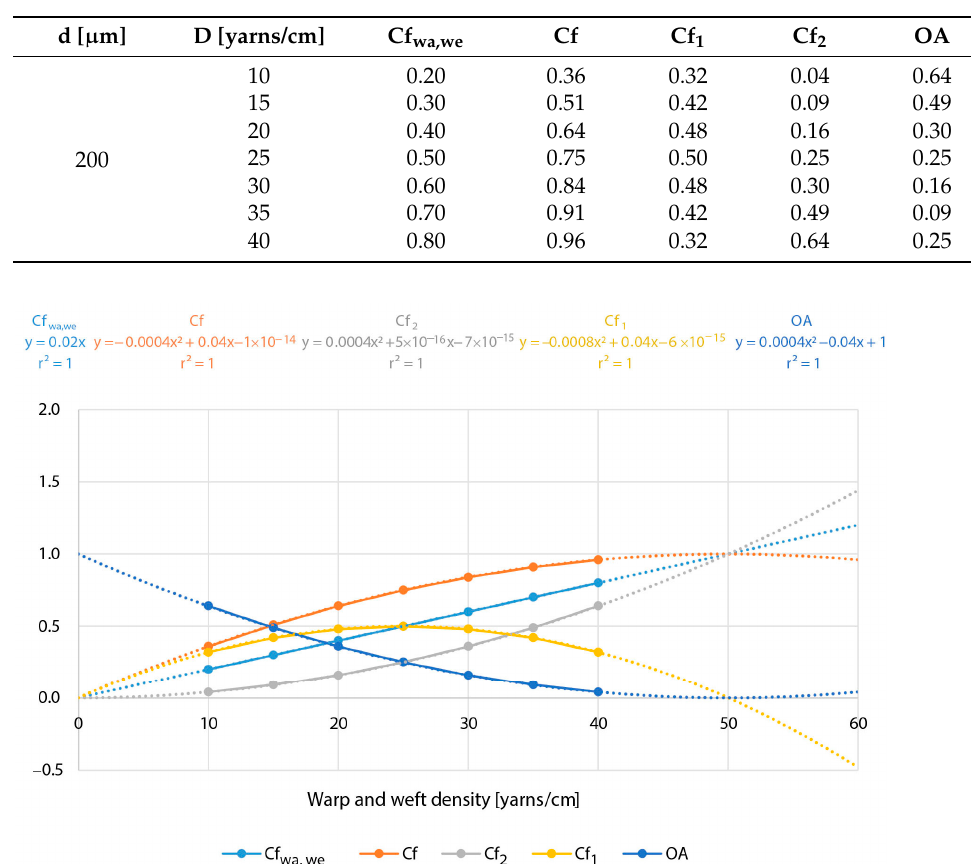
Table 1. Calculated Cf wa,we, Cf, Cf 1 , Cf 2 , and open area (OA) depending on the given ideal yarn diameter (d) and different densities of warp and weft (D).